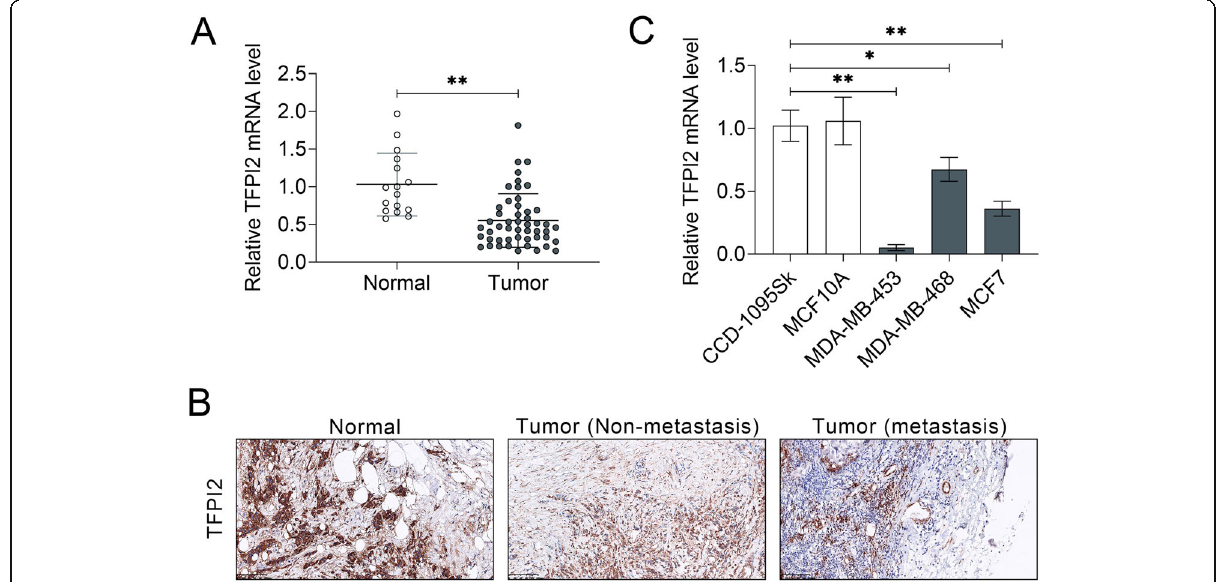
Fig. 1 TFPI2 was down-regulated in breast cancer tissues and cell lines. a The expression of TFPI2 was down-regulated in breast cancer (Tumor) compared to normal breast specimens (Normal). ** represents Tumor vs. Normal tissues, P < 0.01. b Immunohistochemistry of TFPI2 in Normal, Non-metastasis or metastasis breast cancer tissues, suggesting down-regulation of TFPI2 in breast cancer tissues. c The expression of TFPI2 was down-regulated in human breast cancer cell lines (MDA-MB-453, MDA-MB-468 and MCF7) compared to CCD-1095Sk and MCF 10A. *, ** represents breast cancer cell lines vs. CCD-1095Sk, P < 0.05, P < 0.01